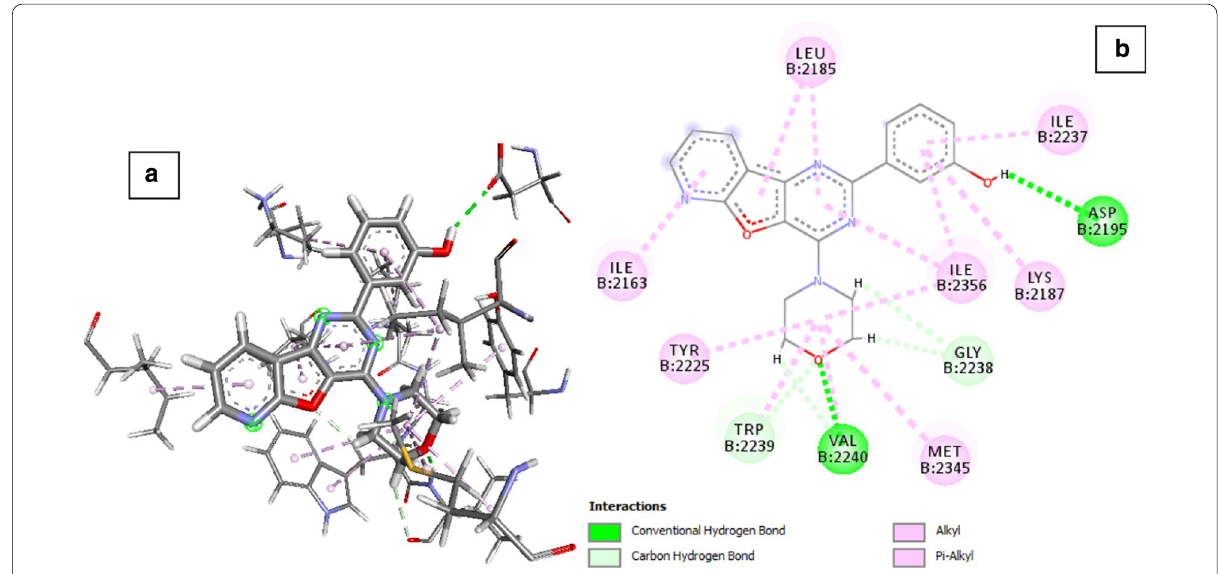
Fig. 3 3D and 2D binding pose interaction of X6K- mTOR kinase complex in a and b respectively. 2D 2dimension, 3D 3dimension